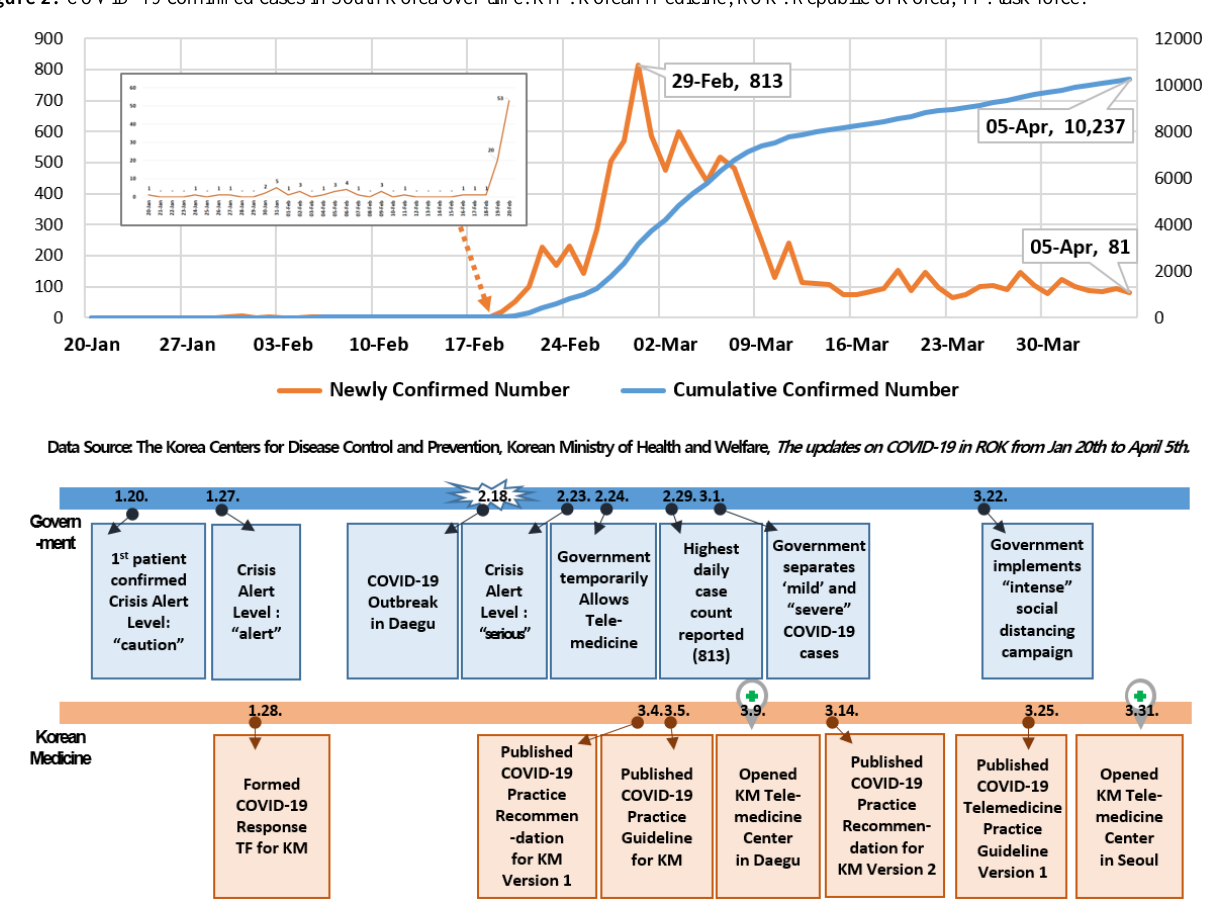
Figure 2. COVID-19 confirmed cases in South Korea over time. KM: Korean Medicine; ROK: Republic of Korea; TF: task